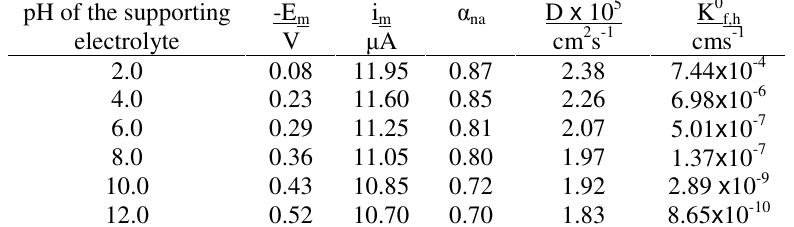
Table 2. Typical differential pulse polarographic data of zileuton, Concentration: 0.5 mM, drop time: 2 sec.